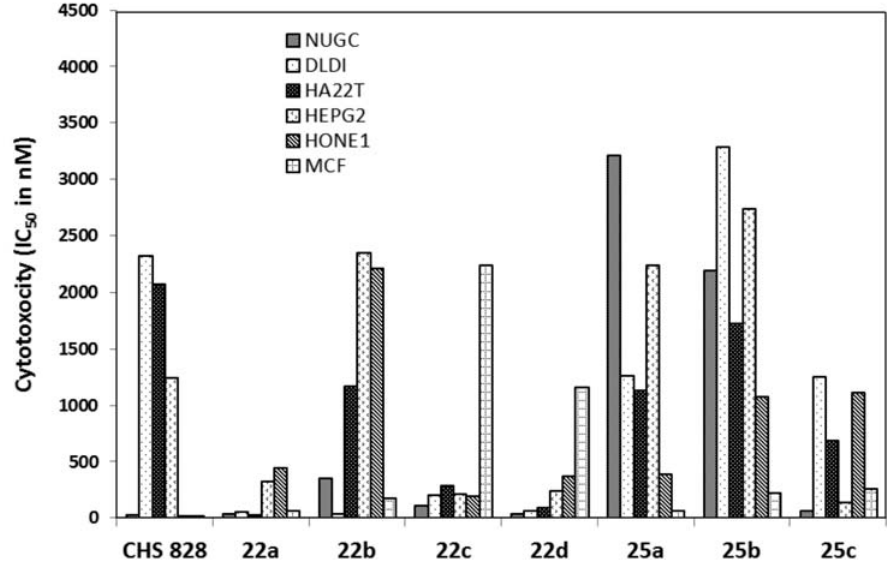
Figure 4 . Cytotoxicity of compounds 22a – d , 25a – c and CHS 828 against NUGC (gastric cancer); DLDI (colon cancer); HA22T and HEPG2 (liver cancer); HONE1 (nasopharyngeal carcinoma); MCF (breast